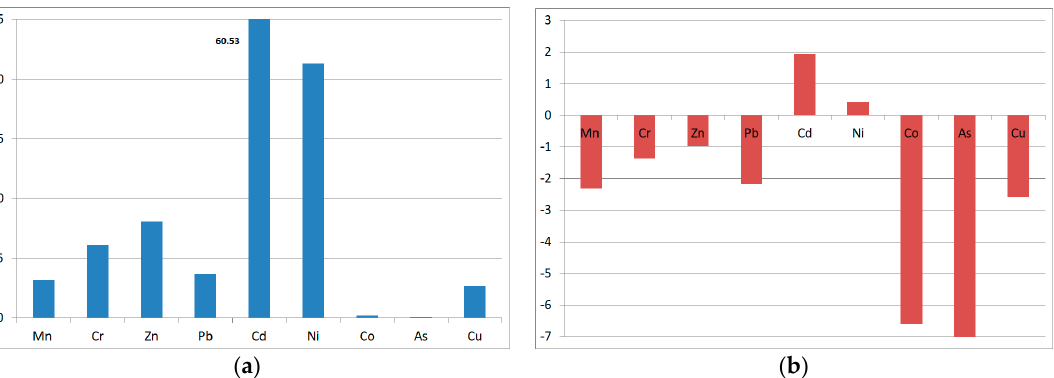
Figure 5. The average ( a ) geo-accumulation index (I geo ), ( b ) enrichment factors (EF)relative to the average upper continental crust for heavy metals in the soil samples collected from Liwa, Abu Dhabi, UAE.